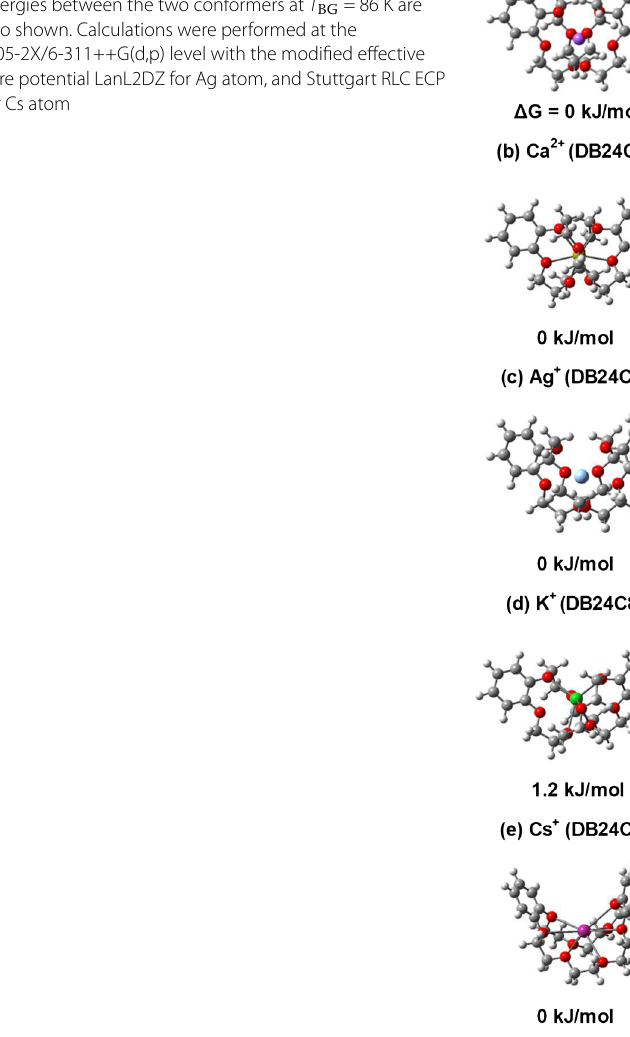
Figure 10 Most stable open and closed conformers of ( a ) Na + (DB24C8), ( b ) Ca 2+ (DB24C8), ( c ) Ag + (DB24C8), ( d ) K + (DB24C8), and ( e ) Cs + (DB24C8). Relative Gibbs energies between the two conformers at T BG = 86 K are also shown. Calculations were performed at